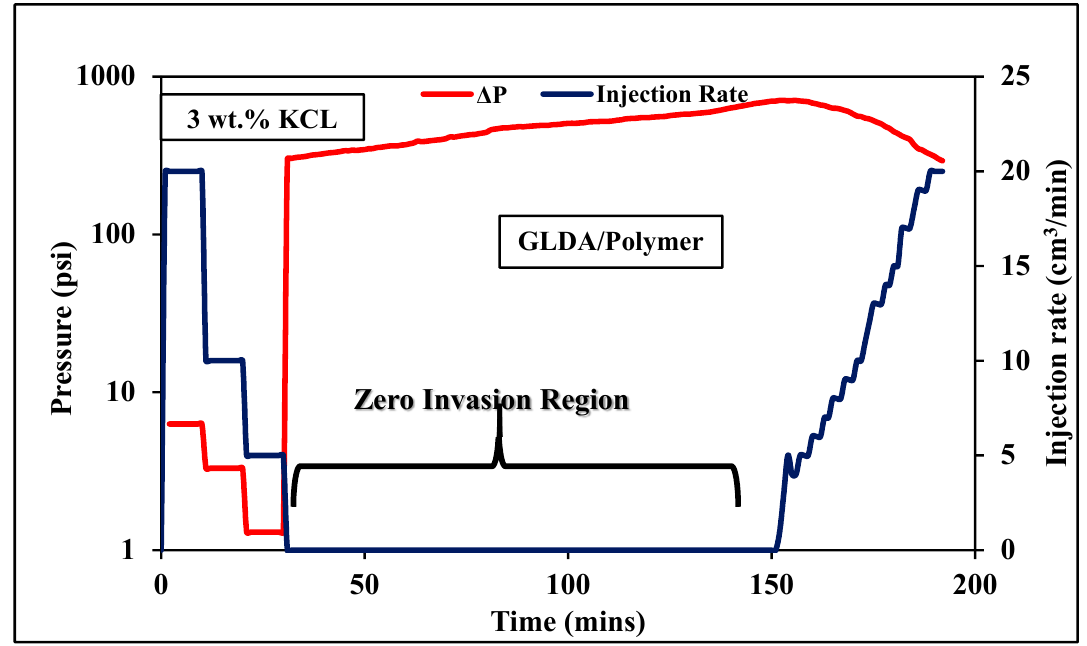
Figure 11. Coreflooding data for the GLDA-XC polymer solution.